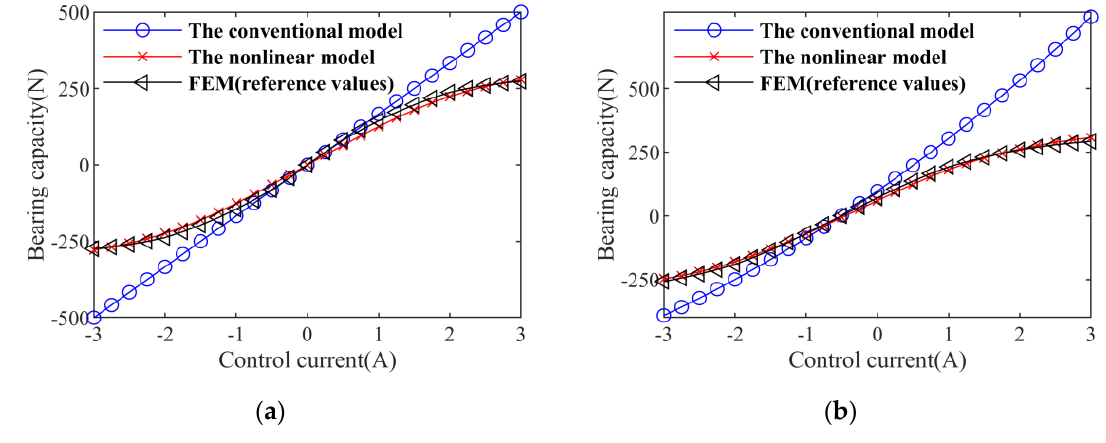
Figure 4. Each reluctance calculation by using NMCM. ( a ) The air gap reluctance model; ( b ) the leakage reluctance model; ( c ) the magnetization curve points of soft magnetic materials and their fitting curve.